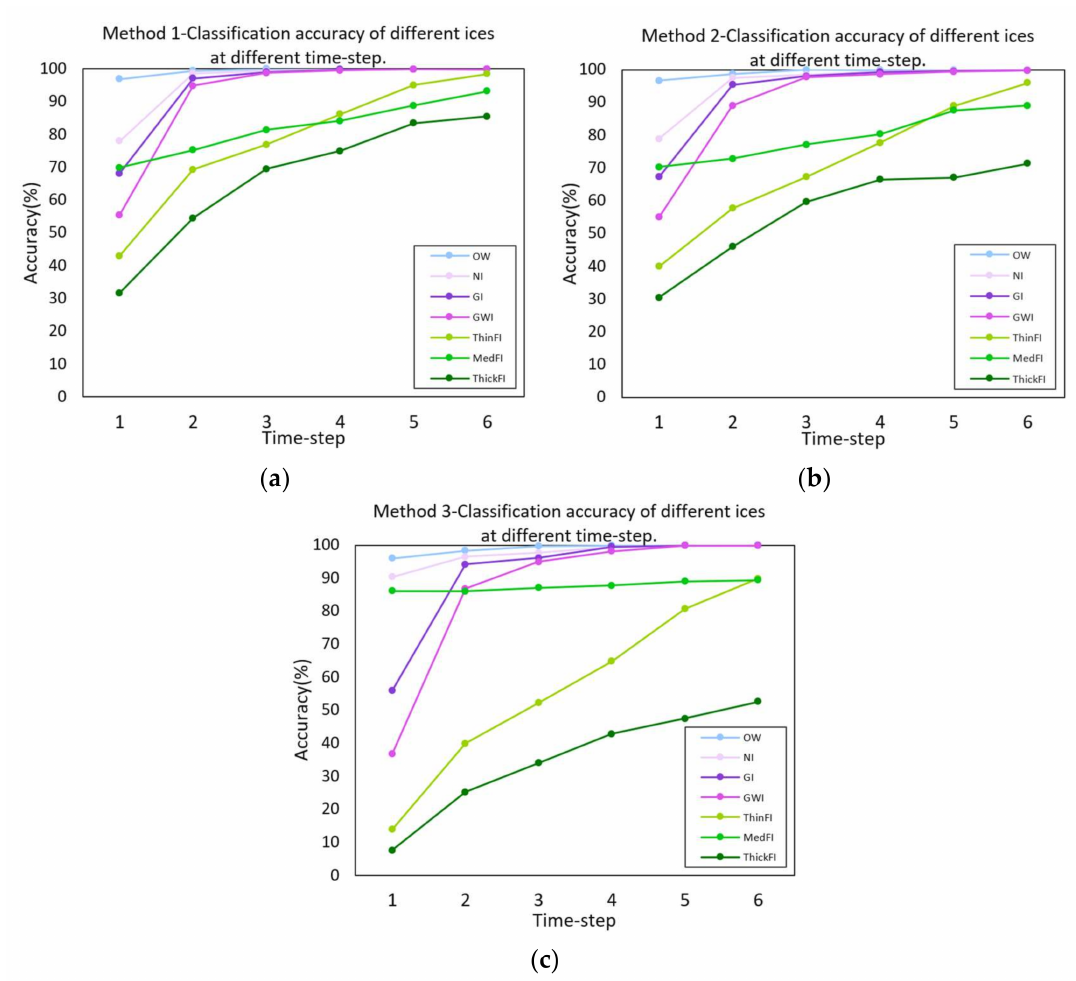
Figure 9. Accuracy of the baseline methods for different sea ice types at different time-steps. ( a ) Method 1; ( b ) Method 2; ( c ) Method